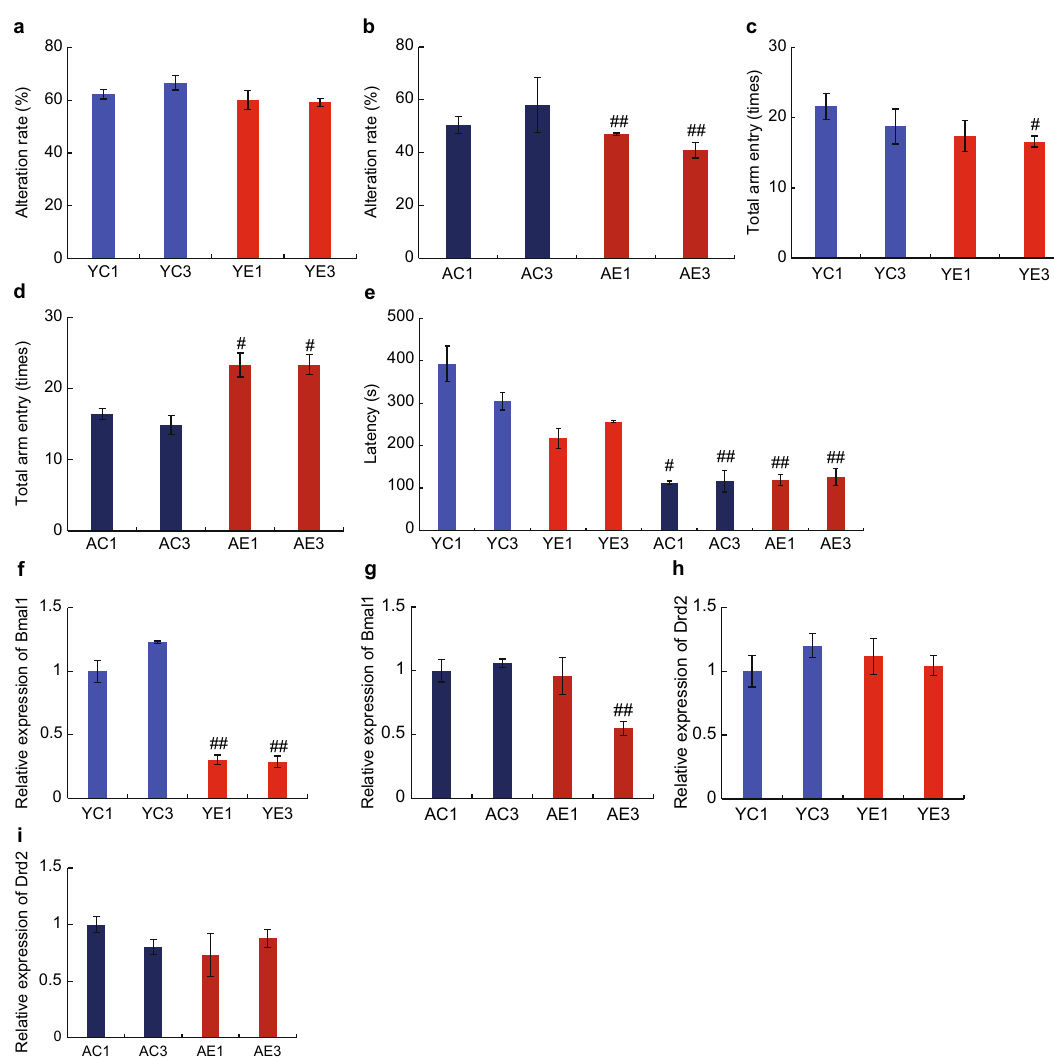
Figure 2. Effects of maxillary molar loss on mouse memory and behavior. ( a ) The alteration rate in young mice in the Y-maze experiment. ( b ) The alteration rate in aged mice in the Y-maze experiment. ( c ) Total arm entry in the young group in the Y-maze experiment. ( d ) Total arm entry in aged mice in the Y-maze experiment. ( e) Latency in young and aged mice in the rotarod experiment. ( f,g ) Expression of Bmal1 in the hypothalamus. ( h,i ) Expression of Drd2 in the hypothalamus. ## P < 0.01; # P < 0.05 vs. control (Tukey’s post-hoc test). Results are presented as means ± SE. YC(E)1, YC(E)2, and YC(E)3 represent young mice groups immediately after tooth extraction, 1 month after, and 3 months after tooth extraction, respectively. The teeth of aged mice were extracted at 18 months of age, AC(E)1 indicates mice aged 18 months, AC(E)2 indicates 1 month after (19 M), and AC(E)3 indicates 3 months (21 M) after tooth